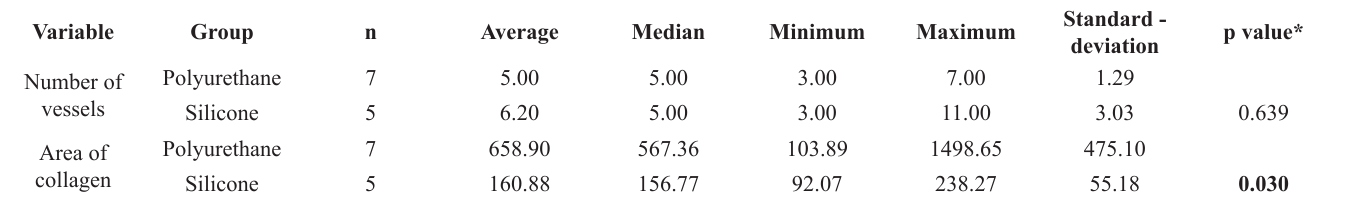
TABLE 6 - Subgroups of two months comparing number of vessels and collagen area.